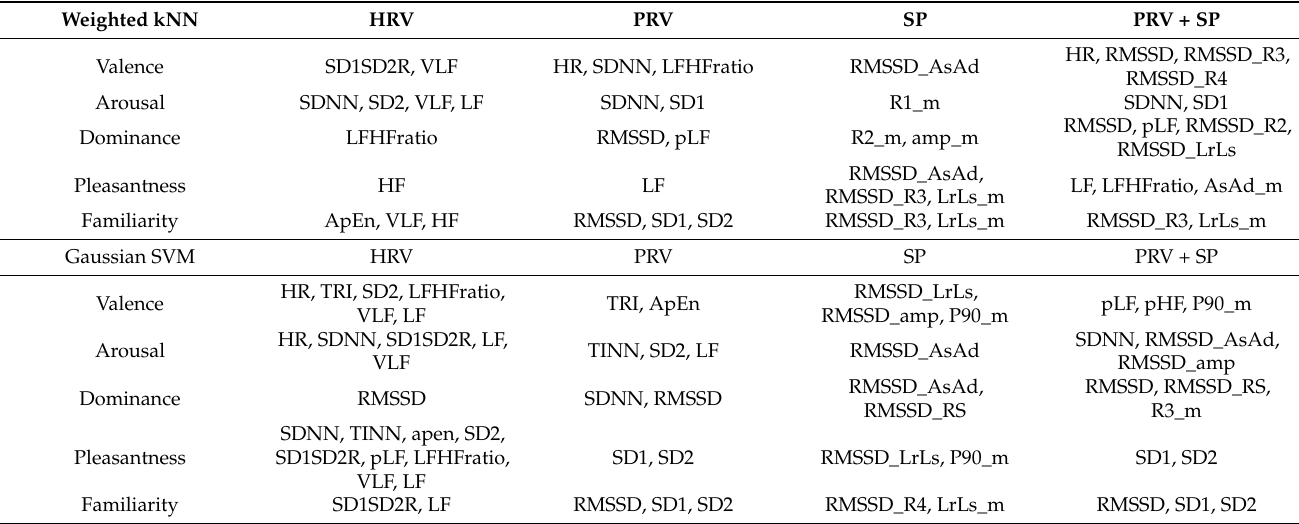
Table 8. Relevant